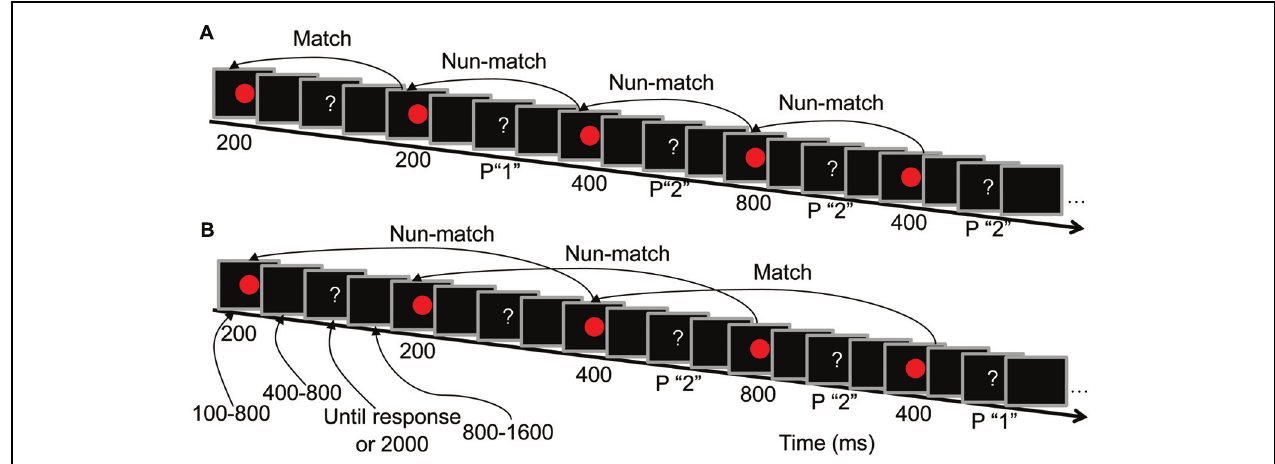
FIGURE 1 | Trial sequences and the duration of each screen presentation. (A) Low load condition (LL, 1-back task) procedures. (B) High load condition (HL, 2-back task) procedures. P “1” indicates that pressing “1” is the correct response, and P “2” indicates that pressing “2” is the correct response.